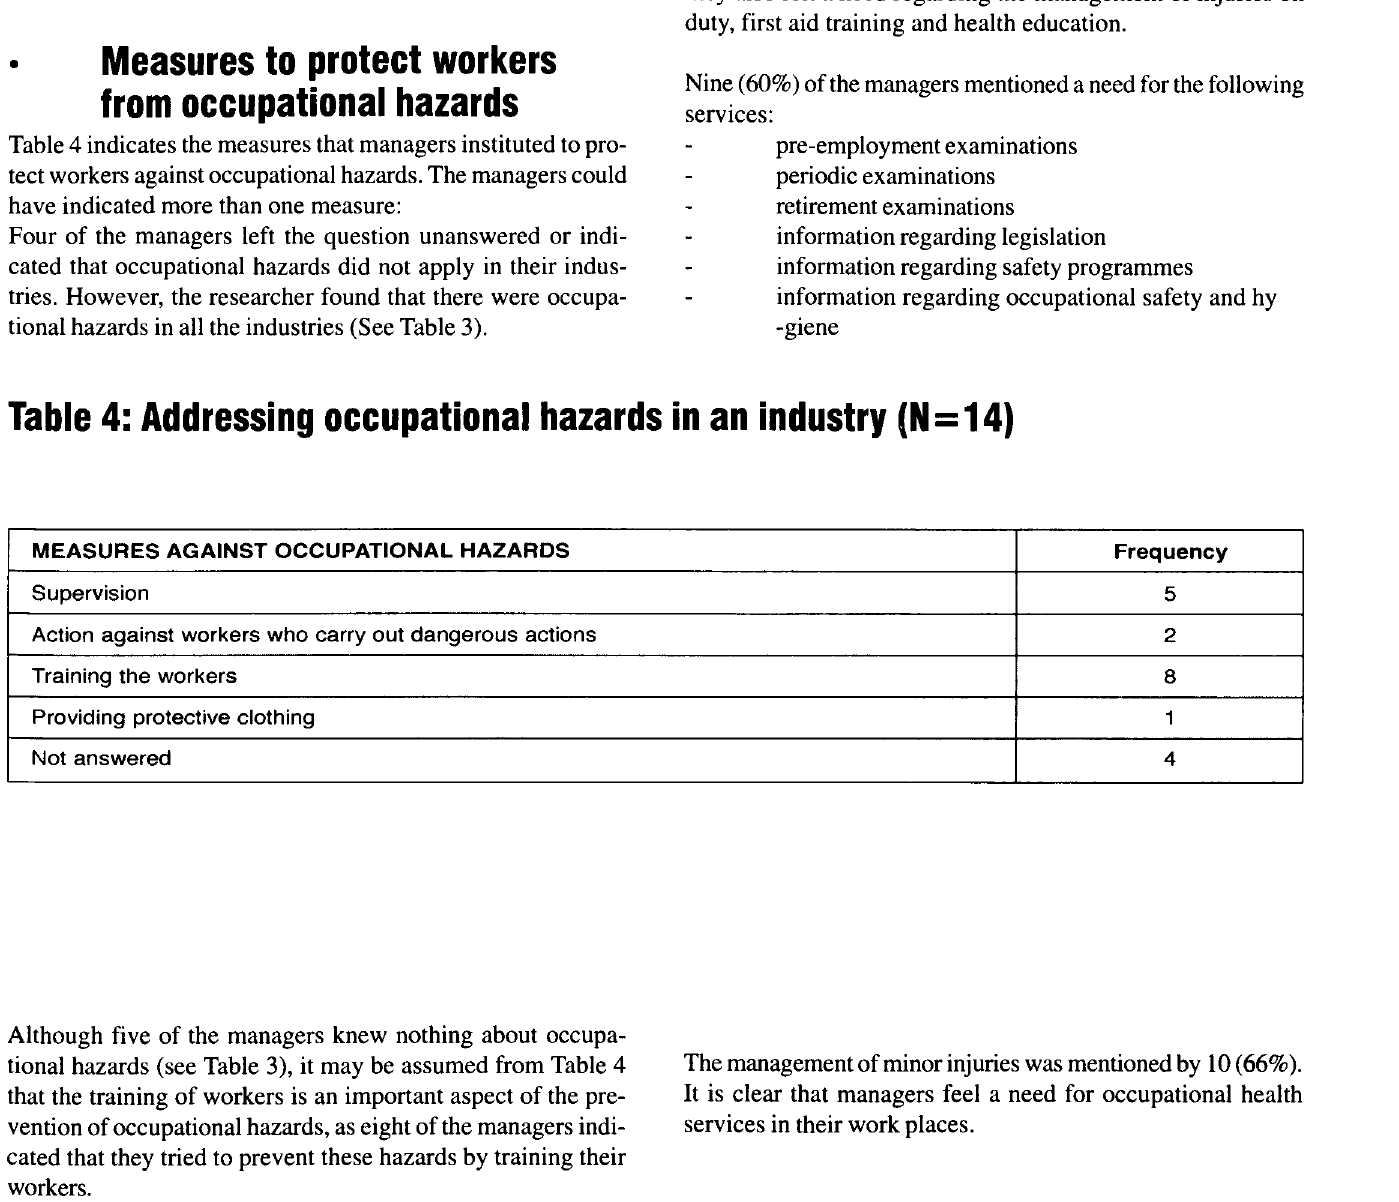
MEASURES AGAINST OCCUPATIONAL